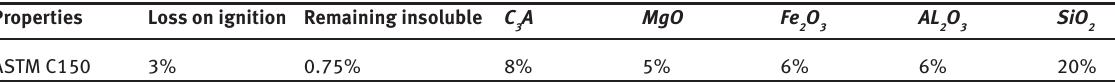
Table 4: Chemical properties of cement.